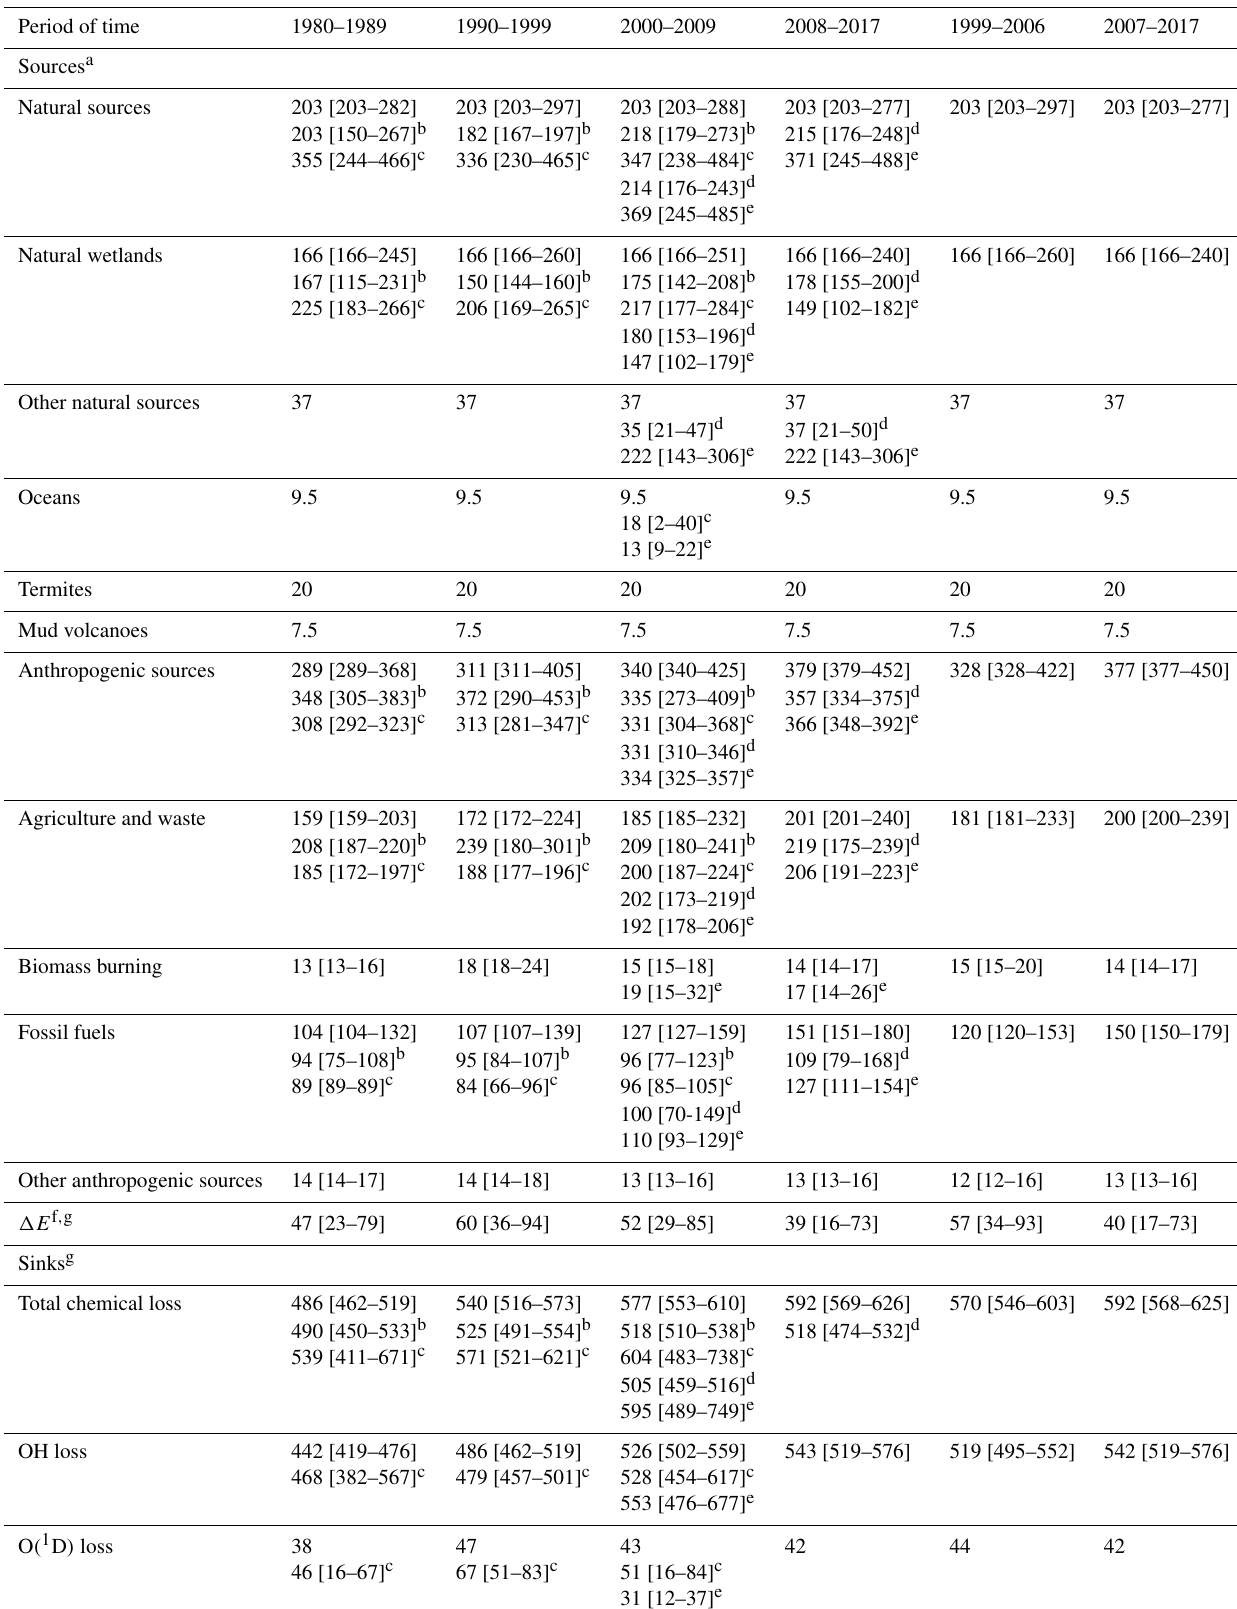
Table 4. Global methane budget (TgCH 4 yr − 1 ) during